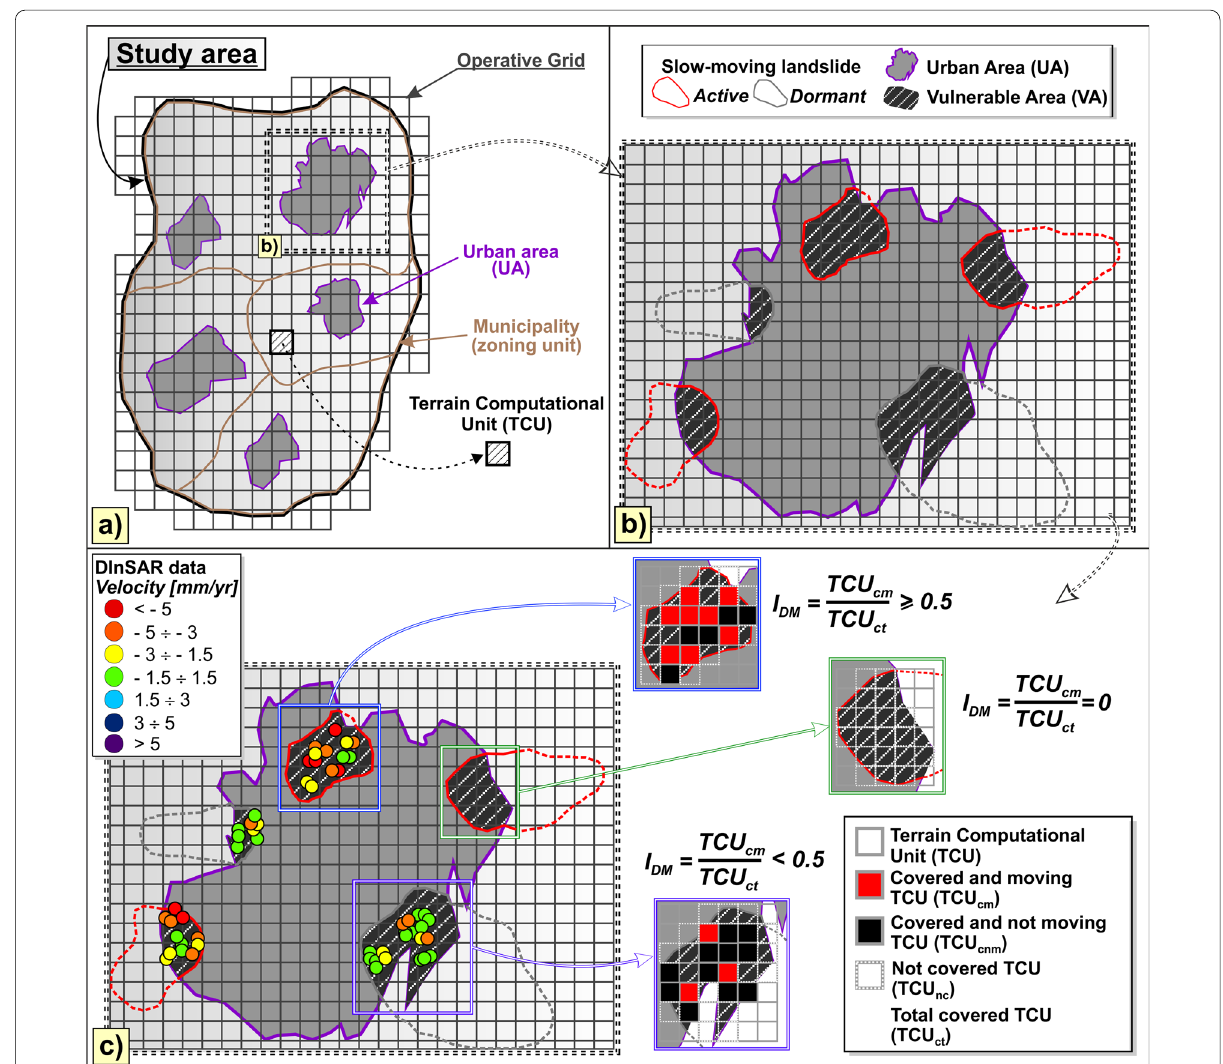
Fig. 2 a Sketch of an operative grid composed by Terrain Computational Units (TCUs) to be defined over the study area and zoning units; b an example of Vulnerable Area (VA) deriving from the intersection of the built-up urban area with the slow-moving landslides (SMLs); c calculation of the Index of DInSAR-based movement (I DM